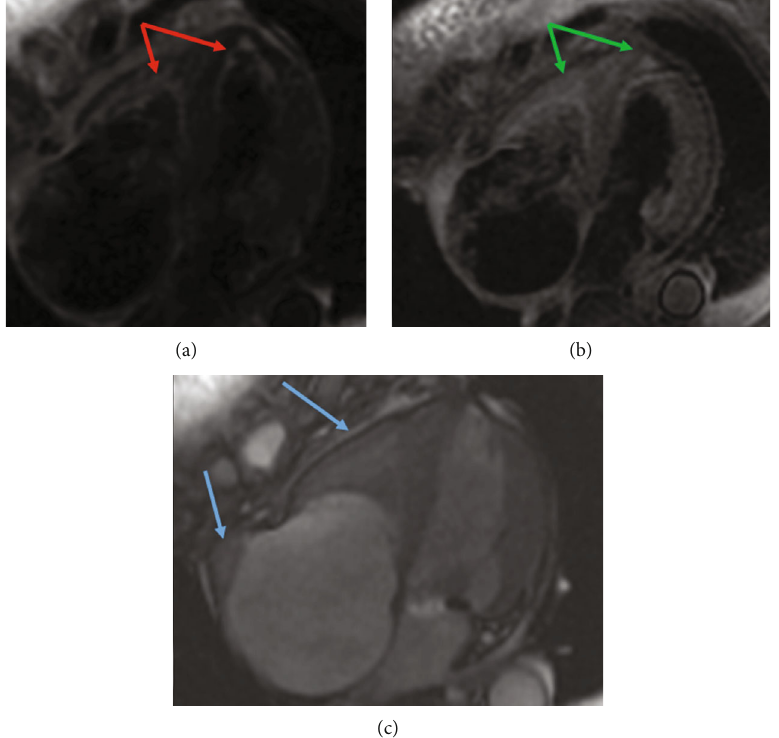
Figure 4: CMR. (a) Double inversion recovery (IR) T2-weighted axial imaging showing increased signal intensity of myocardium in the appendix of left and right ventricles consistent with myocardial edema (red arrows). (b) Tripe IR T1-weighted fat saturation axial image showing again signal intensity in the myocardium (green arrows). (c) Balanced steady state free precession (bSSFP) horizontal long axis still frame showing increase signaling with severe right atrial enlargement and possible thrombus (blue